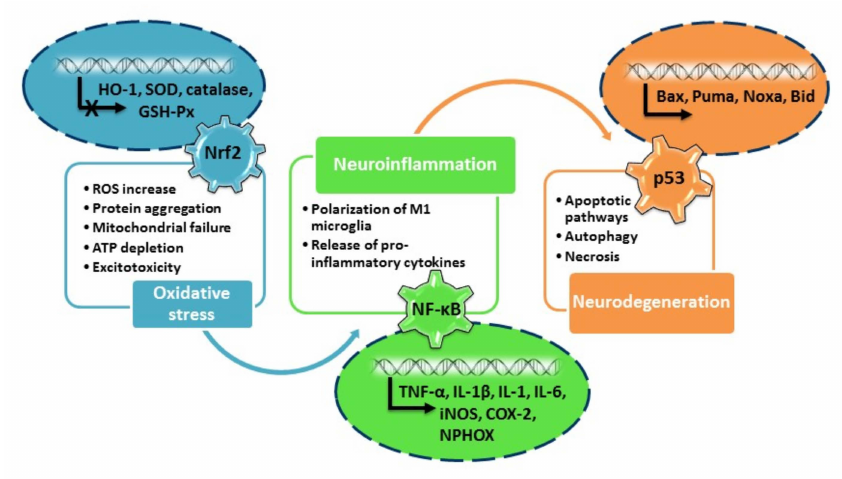
Figure 2. The involvement of transcription factors Nrf2, NF- κ B and p53 in oxidative stress, neuroin- flammation and